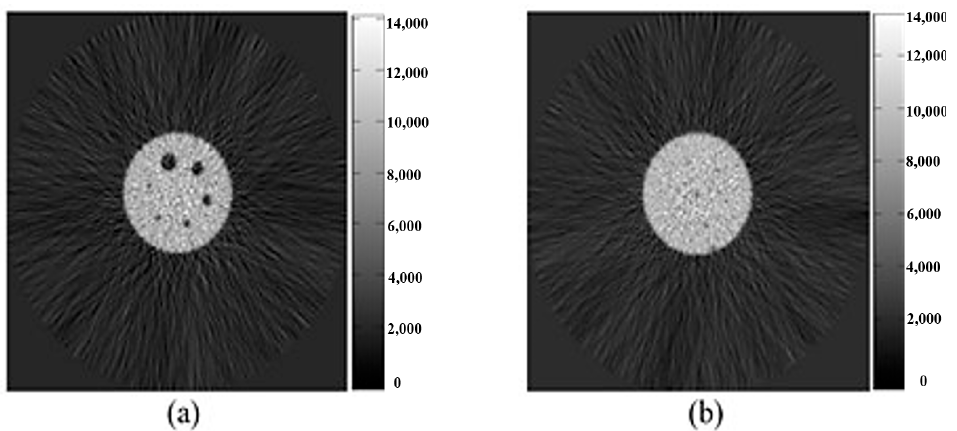
Figure 1. FBP images of the Deluxe Jaszczak phantom that was scanned continuously for 20 min with 74 MBq of 18 F-Fluorine on the 1st ( a ) and 32nd ( b ) slices. The rats (Figure 2) were scanned using MicroPET R4 with a field of 63 mm. The images of the Deluxe Jaszczak phantom and rats were reconstructed using the FBP algo- rithm. The rat image sizes were 256 × 256 and 63 slices, and the total pixel sizes were 256 × 256 × 63.